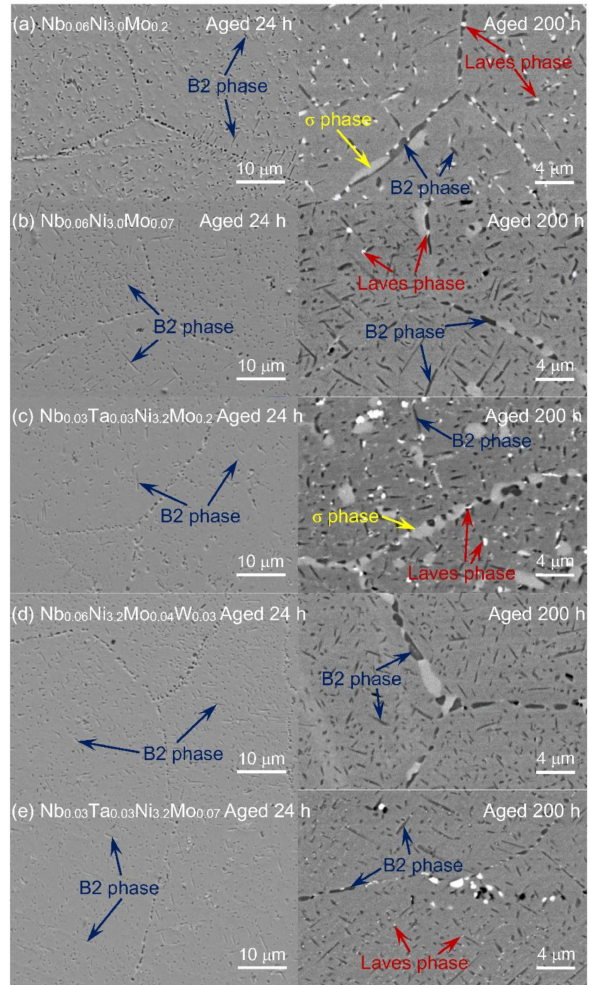
Figure 4. The SEM morphologies of the designed alloys: secondary electron images after ag- ing at 800 ◦ C for 24 h (left) and backscattered images after aging at 800 ◦ C for 200 h (right). ( a ): Nb 0.06 Ni 3.0 Mo 0.2 , ( b ): Nb 0.06 Ni 3.0 Mo 0.07 , ( c ): Nb 0.03 Ta 0.03 Ni 3.2 Mo 0.2 , ( d ): Nb 0.06 Ni 3.2 Mo 0.04 W 0.03 , ( e ): Nb 0.03 Ta 0.03 Ni 3.2 Mo 0.07 .